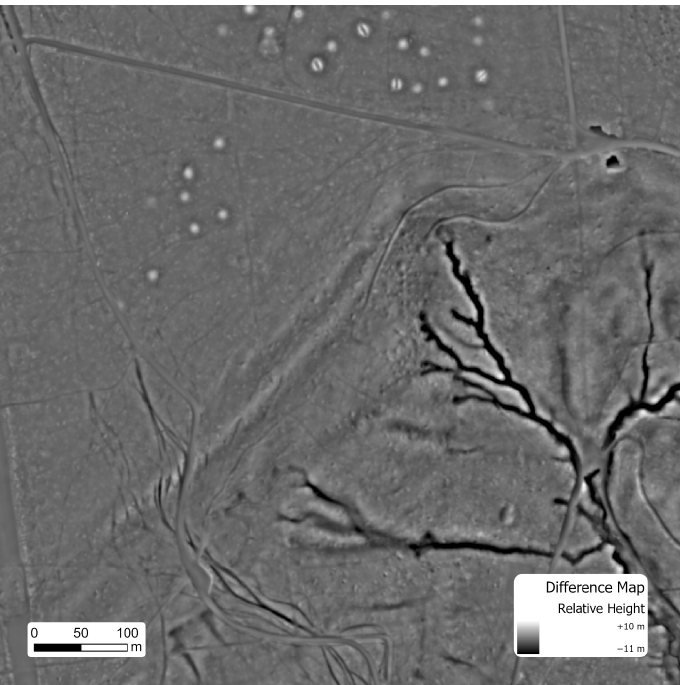
Figure 1. A large burial mound cluster in direct proximity to hollow ways. Data source: [25].